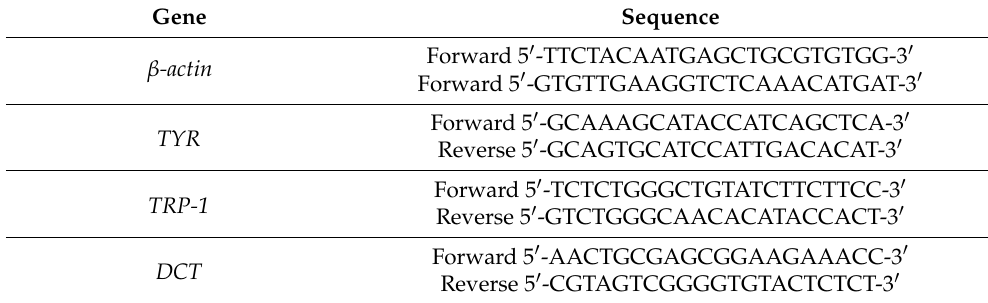
Table 1. RT-qPCR